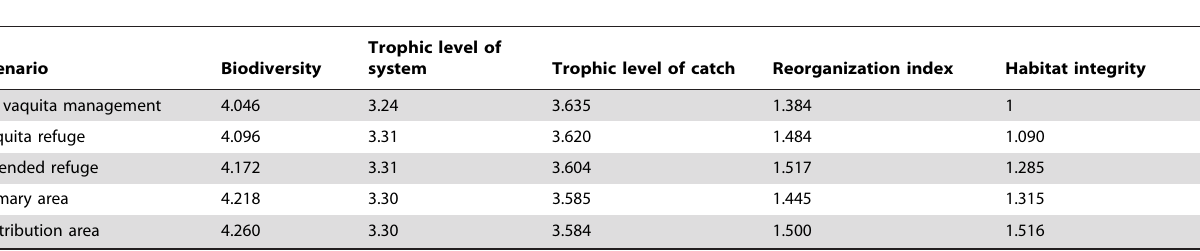
Table 1. Results for performance metrics of ecosystem function and structure for the management scenarios